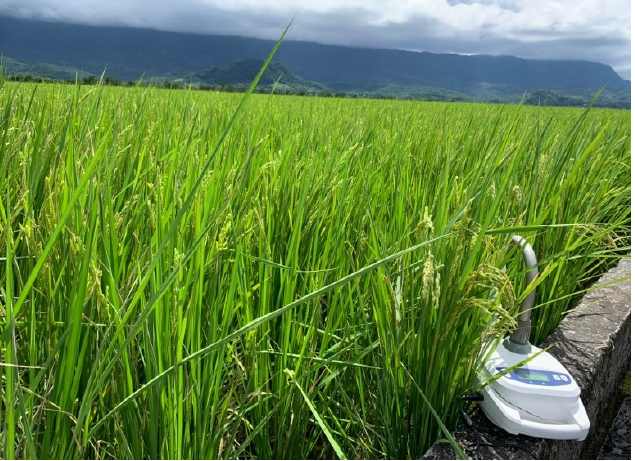
Figure 1. Air samples being drawn at a rice field in Taitung County, Taiwan. Table 1. Details of bacterial species and modes of identification.